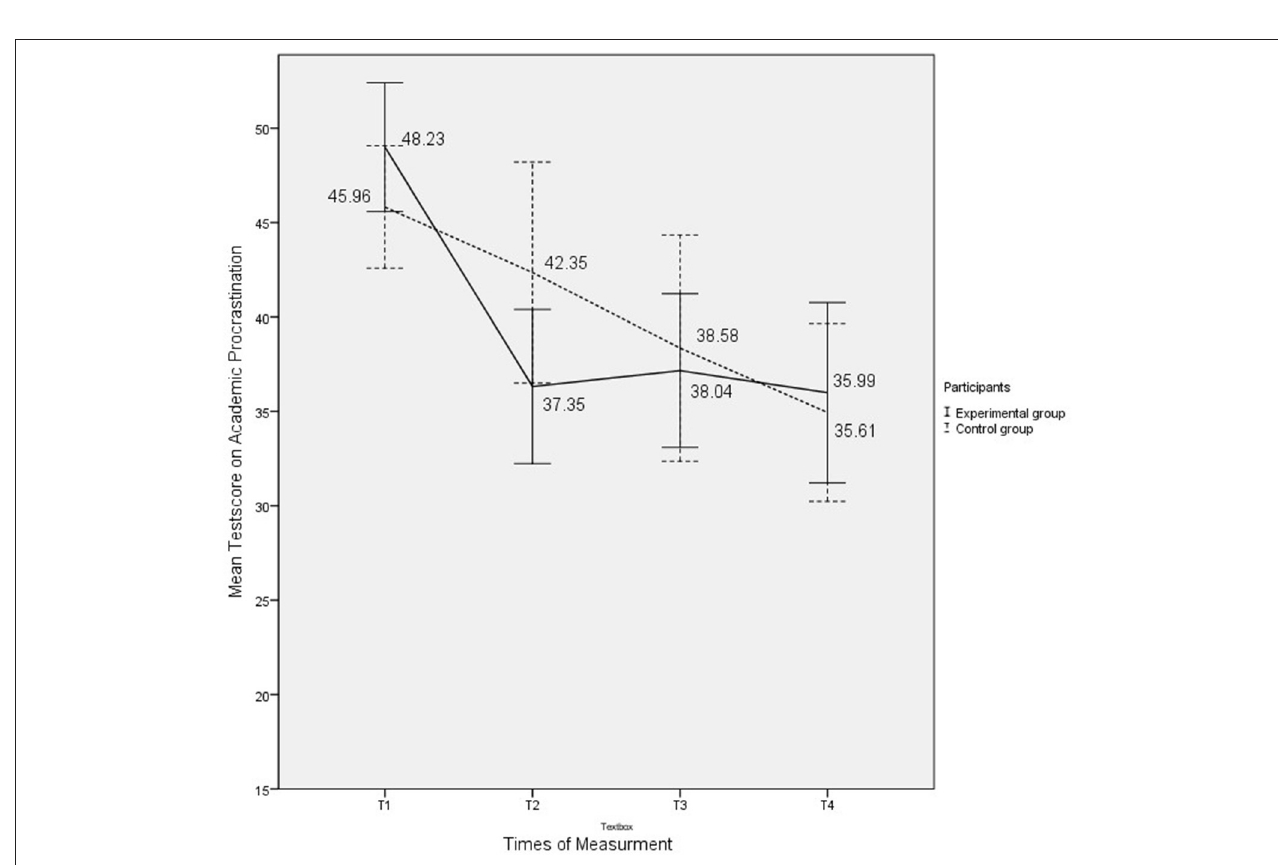
FIGURE 2 | Mean scores before the intervention (T1) and at 1 (T2), 11 (T3), and 24 weeks (T4) after the